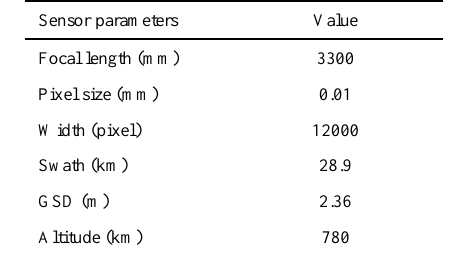
Table 1. Sensor parameters of CBERS-02B HR camera